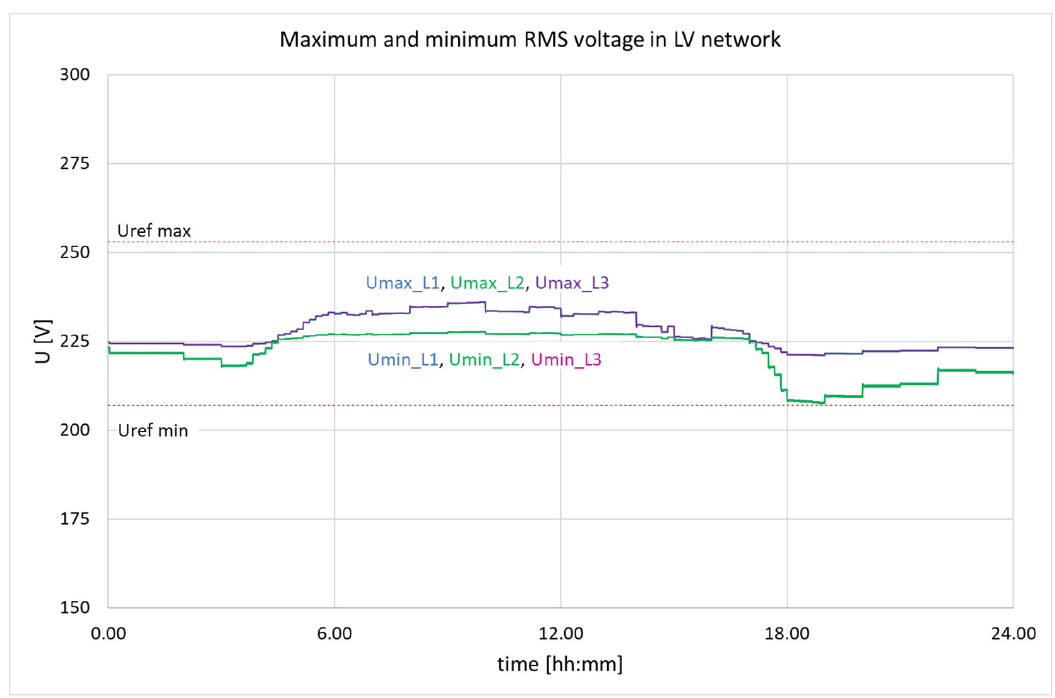
Figure 9. Maximum and minimum phase voltages in the network for one-day simulation period, the case of 3-phase PV inverters in prosumer installations with implemented control algorithm. Lines for corresponding max and min values are overlapping.